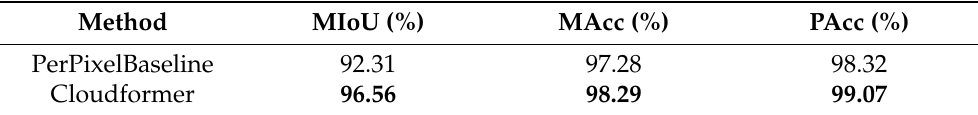
Figure 6. In PerPixelBaseline, the structure of the pixel-level branch is maintained, and the Transformer module is also retained, but, finally, a traditional cross entropy loss is used for per-pixel classification. Table 3. Mask embeddings queries ablation experiment results.